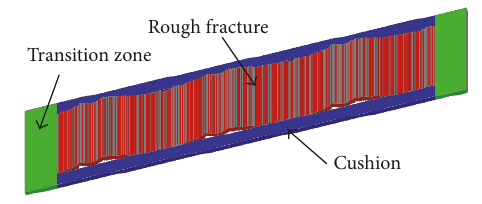
Figure 1: 3D fracture plate model.